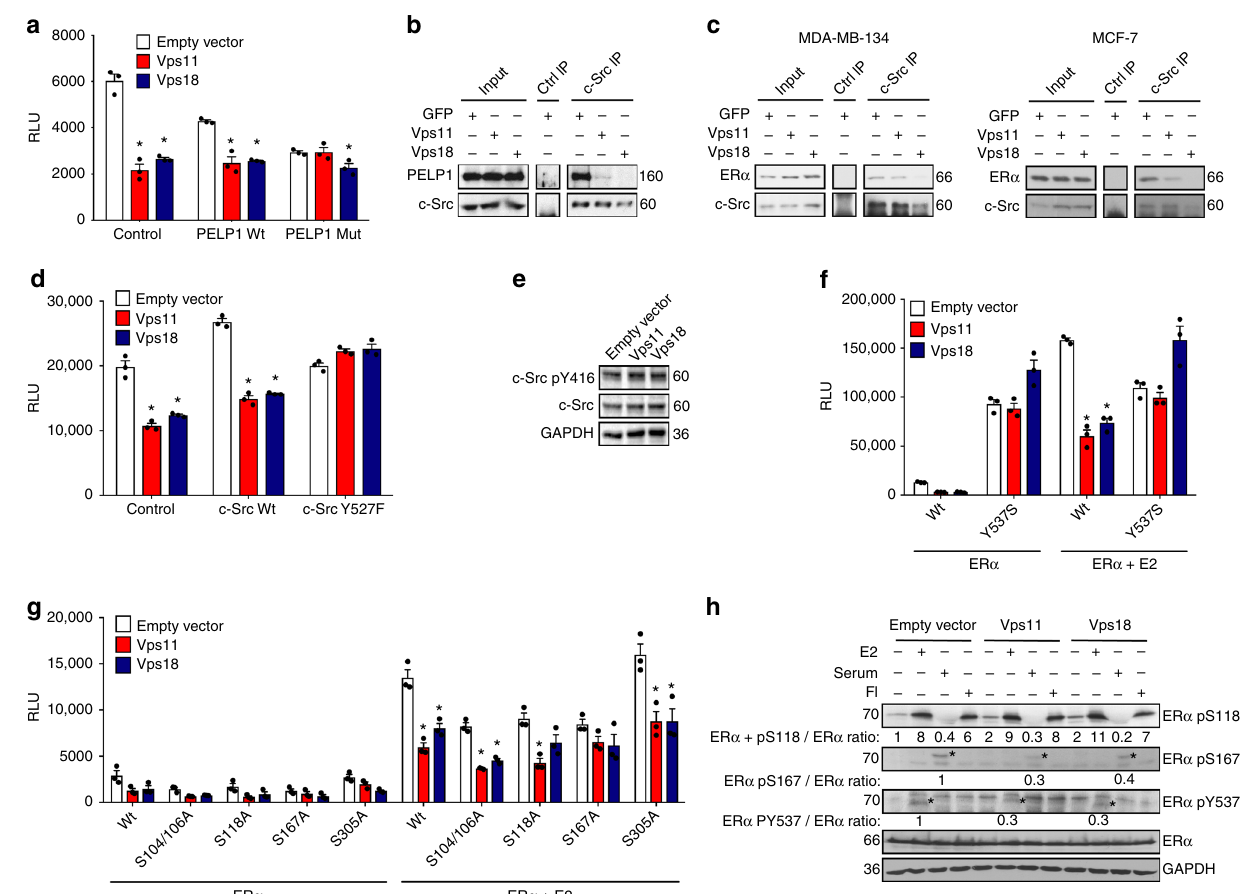
Fig. 6 Vps11/18 regulate the phosphorylation of ER α by c-Src. a Luciferase assay with an ER α -dependent luciferase construct in HEK293T cells overexpressing Vps11/18 along with PELP1 Wt or a mutant of PELP1 48 unable to interact with c-Src (PELP1 Mut) (mean ± s.e.m. with n ≥ 3 biologically independent experiments). b , c PELP1 ( b ) or ER α immunoblot ( c ) of the immunoprecipitations of c-Src with extracts of MDA-MB-134 ( b , c ) or MCF-7 cells ( c ) transiently overexpressing either GFP or Vps11/18 for only 3 days (unlike the prolonged expression in the experiments of Fig. 5d) and treated with E2. d ER α reporter gene assays with HEK293T cells overexpressing Vps11/18 along with either wild-type c-Src (Wt) or the constitutively active c-Src mutant Y527F (mean ± s.e.m. with n = 3 biologically independent experiments). e Immunoblots of phospho-c-Src (Y416) and total c-Src with extracts of HEK293T cells overexpressing Vps11/18. f , g Asssays as in d with the indicated tyrosine ( f ) or serine ( g ) phosphorylation mutants of ER α (mean ± s.e.m. with n = 3 biologically independent experiments). h Immunoblots with antibodies speci fi c for ER α phosphorylation sites with extracts of MDA-MB-134 cells overexpressing Vps11/18; before harvesting, cells were treated with E2, serum or FI for 10 min where indicated; asterisks point out the speci fi c ER α bands; the indicated ratios of phosphorylated ER α /total ER α were determined with the software ImageJ on representative immunoblots. Asterisks indicate signi fi cant differences with the corresponding negative controls with p -values < 0.05. Statistical signi fi cance was determined with unpaired and two-sided Student ’ s t -tests. Source data are provided as a Source Data fi